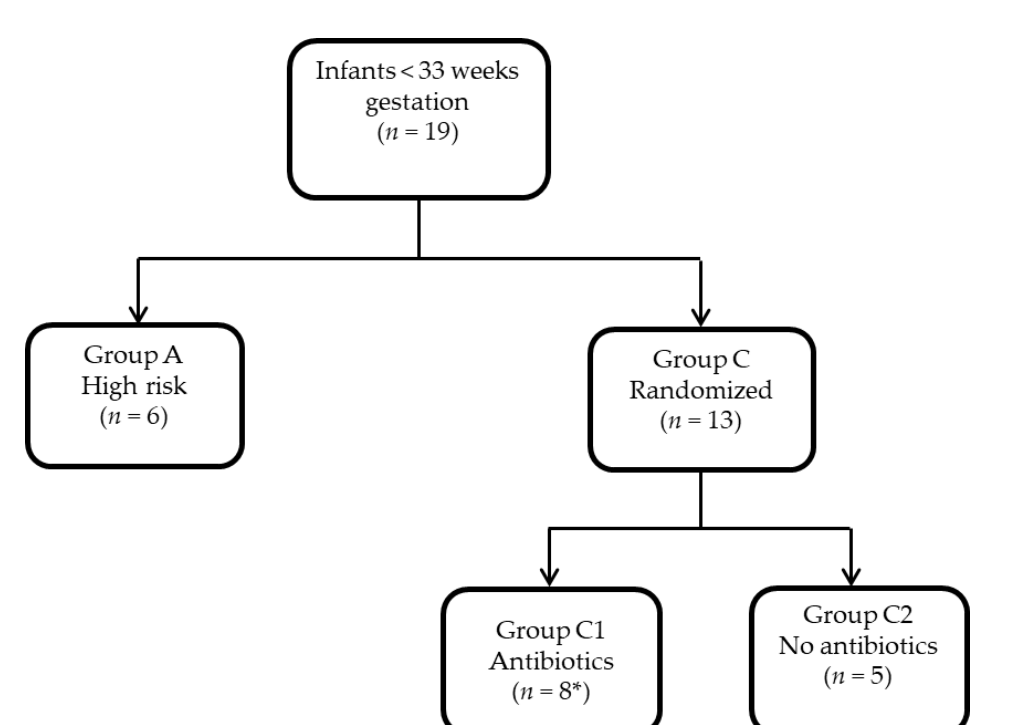
Figure 9. Group schematic. * Represents the total after 3 were bailed from Group C2.